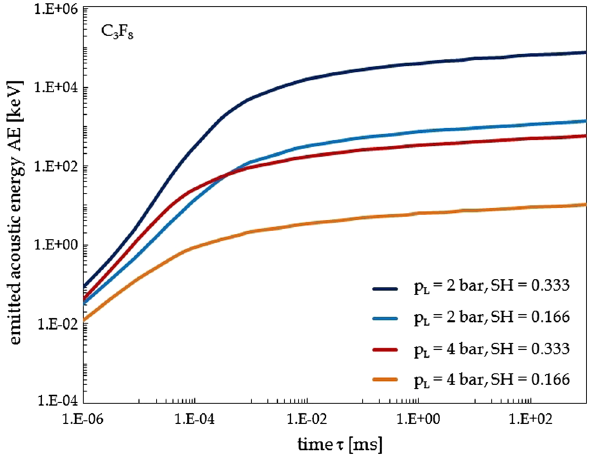
Fig. 6 Distributions of AE vs. time using p L and SH as parameters